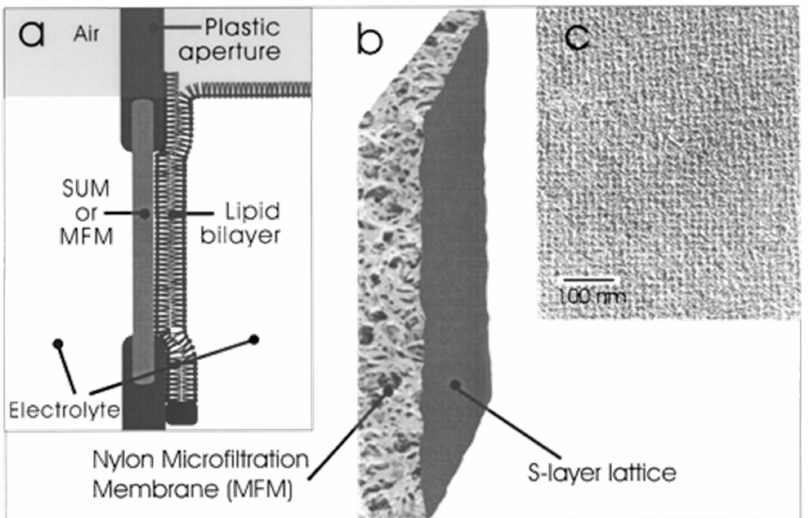
Figure 7. S-layer ultrafiltration membrane (SUM). ( a ) Schematic drawing of an SUM-supported phospholipid bilayer (not drawn to scale). The lipid membrane was generated on the S-layer face of the SUM. ( b ) S-layer fragments were deposited with pressure on a commercially available Nylon microfiltration membrane. ( c ) Transmission electron micrograph of a platinum/carbon replica of a freeze-dried SUM composed of the S-layer protein Lysinibacillus sphericus CCM 2120 showing the square S-layer lattice. (Adapted from [100]. Copyright © 2001 with permission from American Chemical